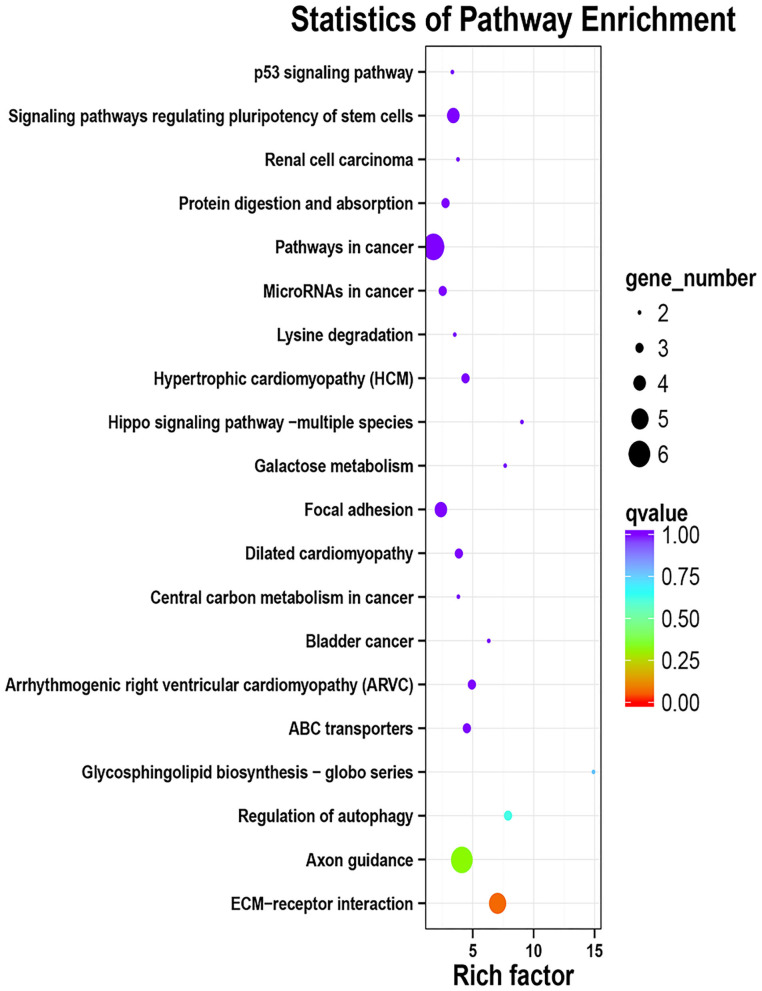
KEGG enrichment analyses of the up-regulated DEGs in jejunum of neonatal goats suffering from diarrhea as compared with control goat kids. The vertical axis represents the pathway category, and the horizontal axis represents Enrichment Factor which means the proportion of DEGs annotated to the pathway on genes annotated to the pathway.